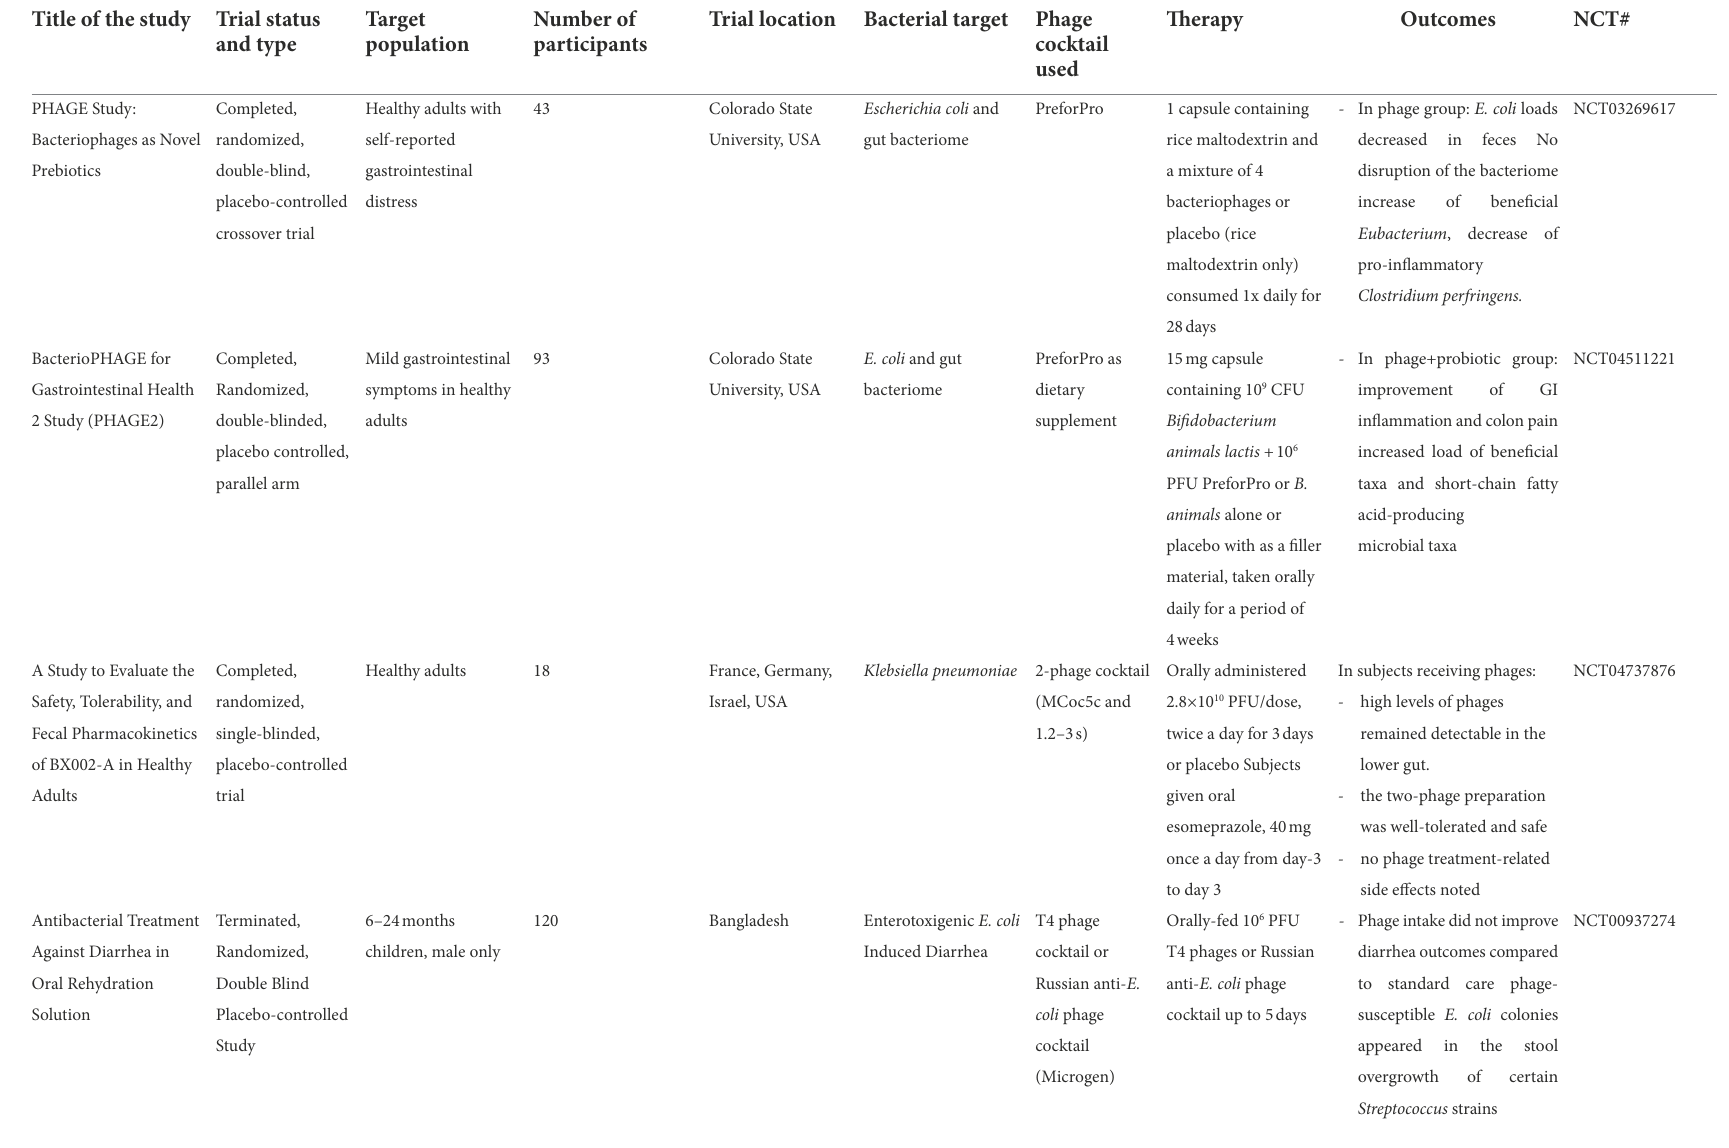
TABLE 1 Summary of interventional clinical trials investigating bacteriophages and GI